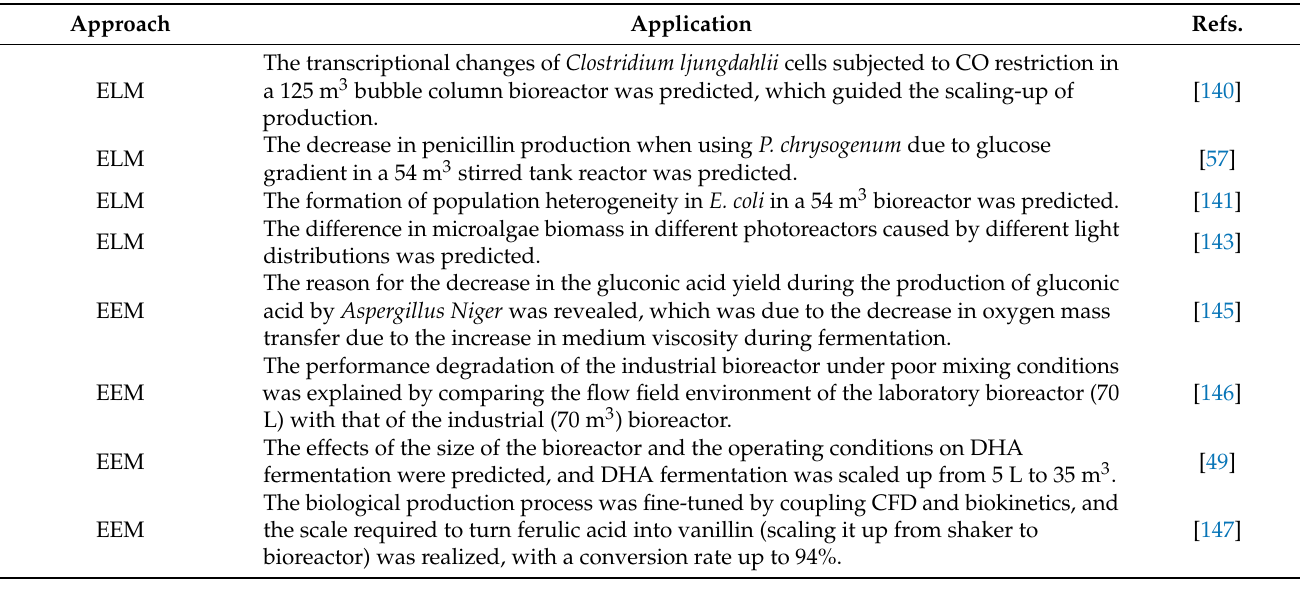
Table 3. Overview of the applications of different kinetics and computational fluid dynamics coupling frameworks used during fermentation.